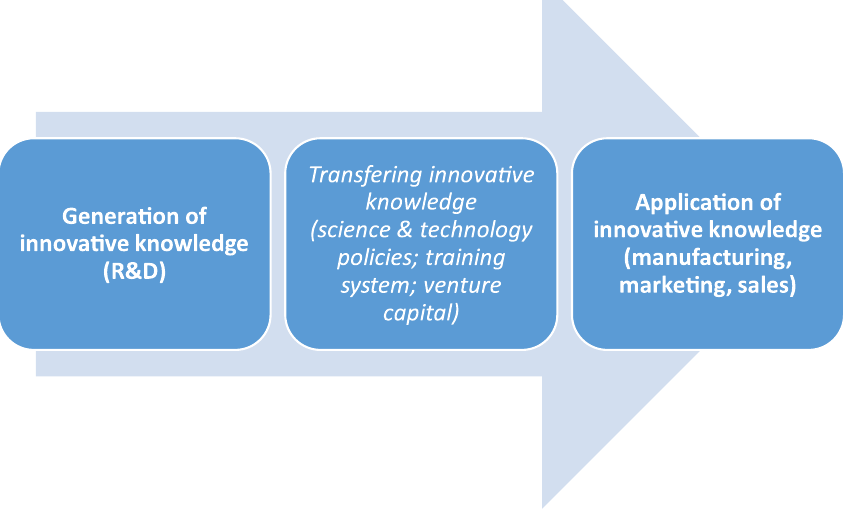
Figure 1. The structure of NIS according to the “narrow” definition of Nelson. Source: authors’ own